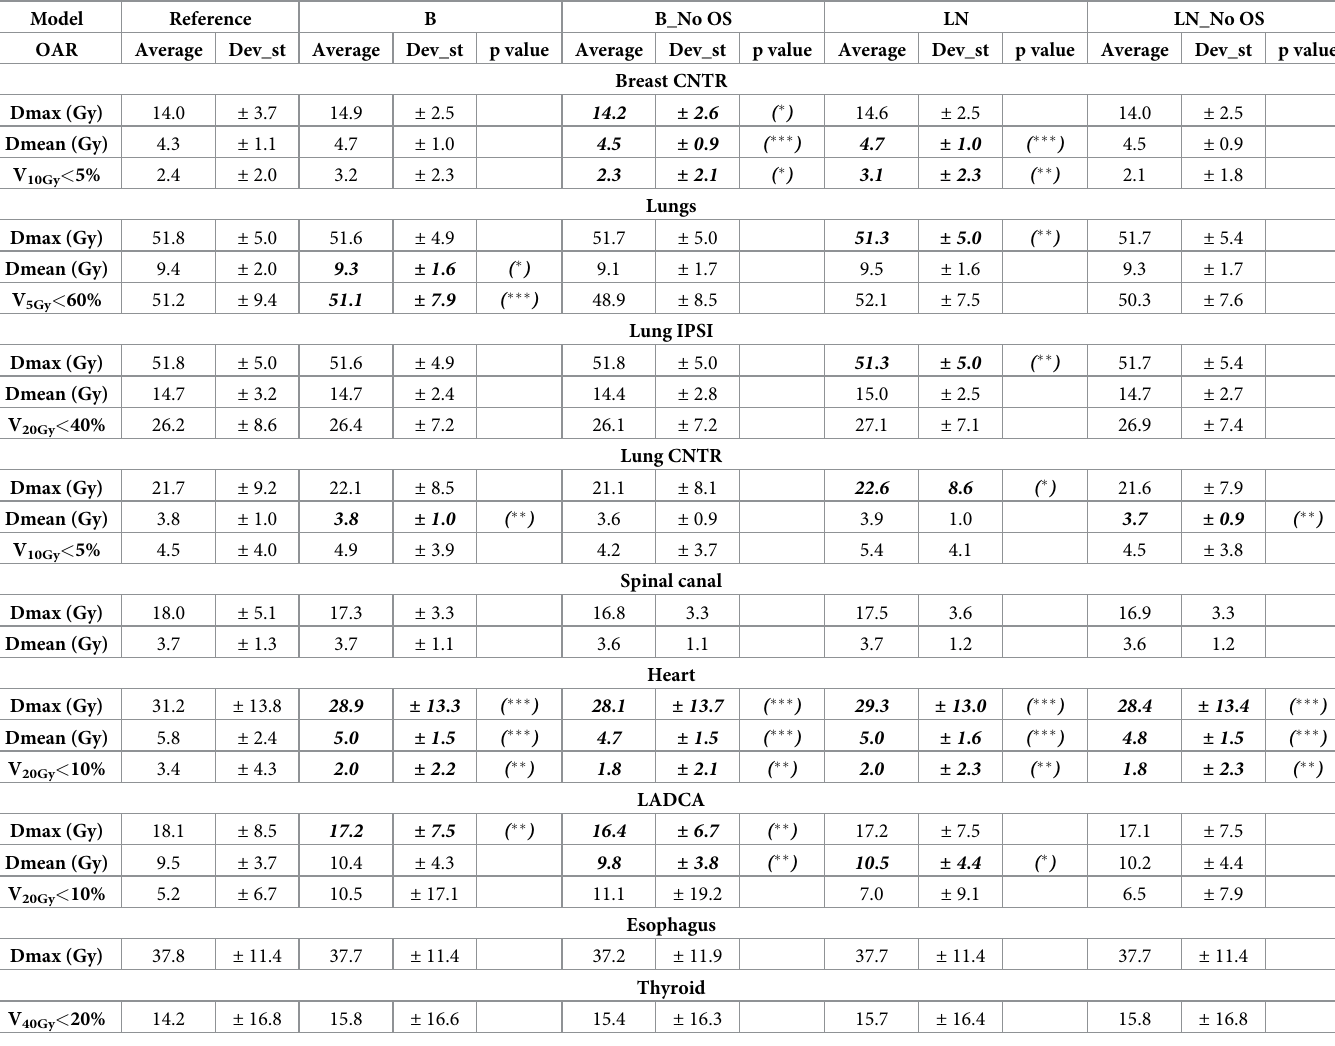
Table 1. Overview and comparison of relevant DVH parameters for OARs, averaged for the 30 patients of validation set, both for reference and model-based plans.